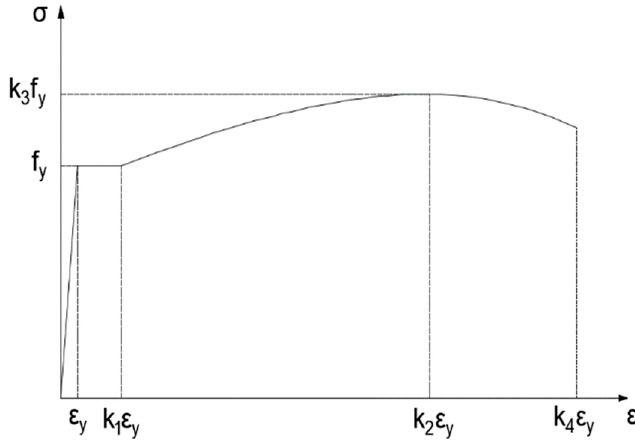
Figure 1. Stress-strain relationship for tensile steel bars.